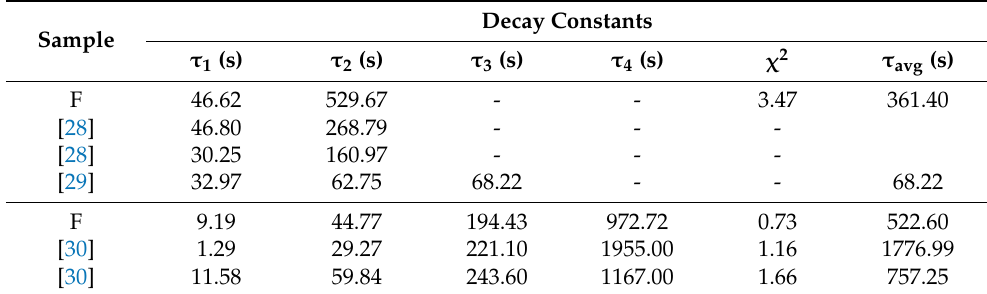
Table 1. Exponential-fitting results.